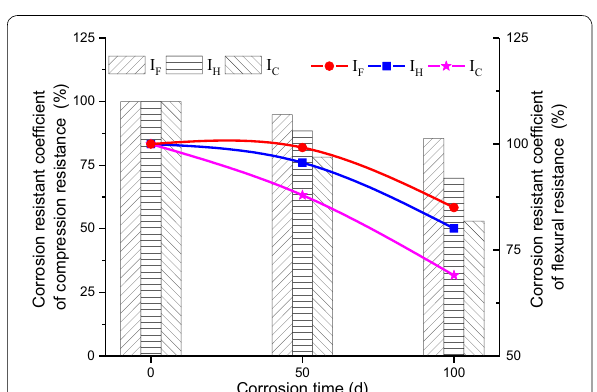
Fig. 4 Effect on strength of C20 concrete caused by three immersion